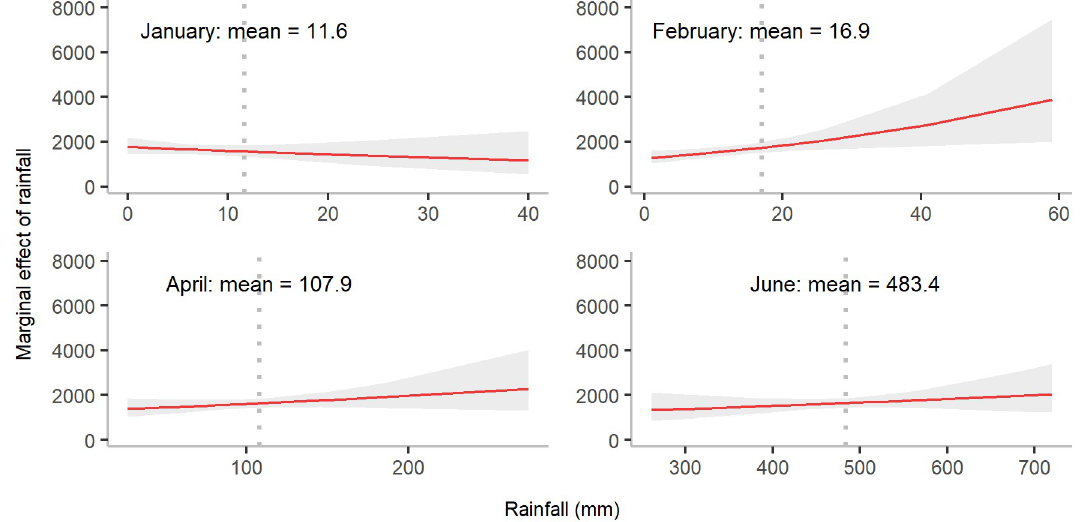
Fig 7. Marginal effect of total rainfall on annual dengue incidence in January, February, April and June. The shaded area denotes the 95% confidence interval of the expected number of annual dengue cases for different values of rainfall whereas the dotted vertical line represents mean rainfall for a month. The marginal effect here represents marginal effects at the mean (MEMs).